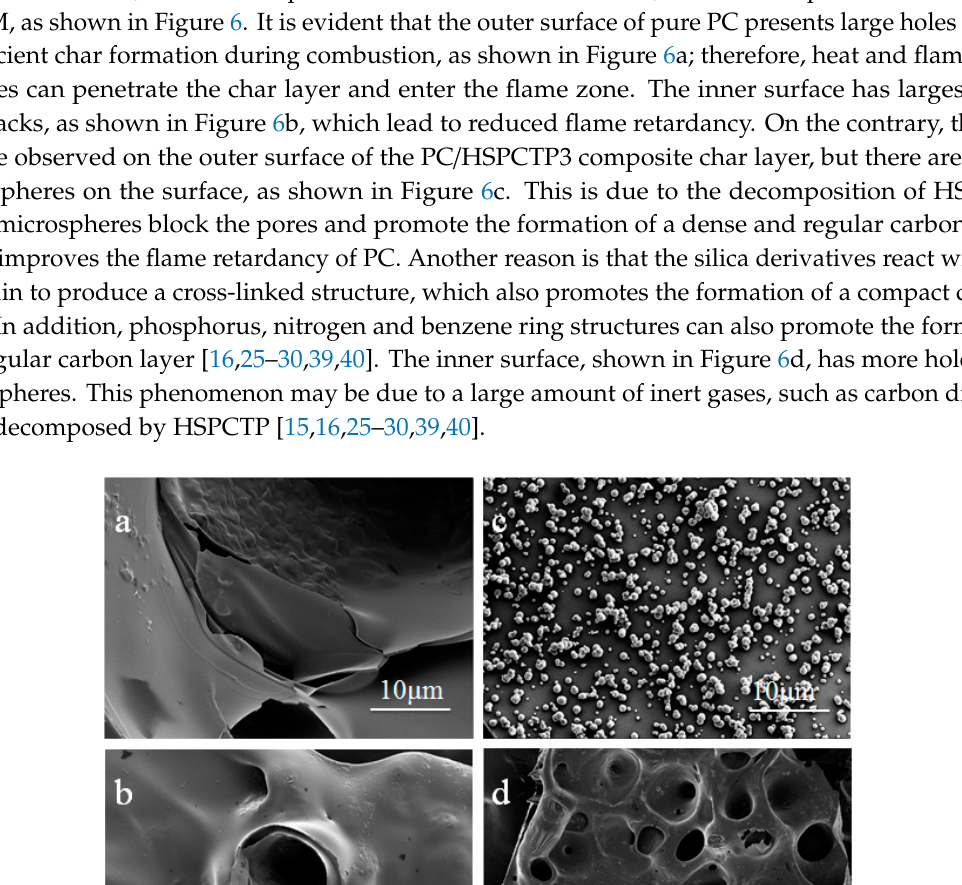
Table 3. Cone calorimeter data for pure PC and PC/HSPCTP3 composites.